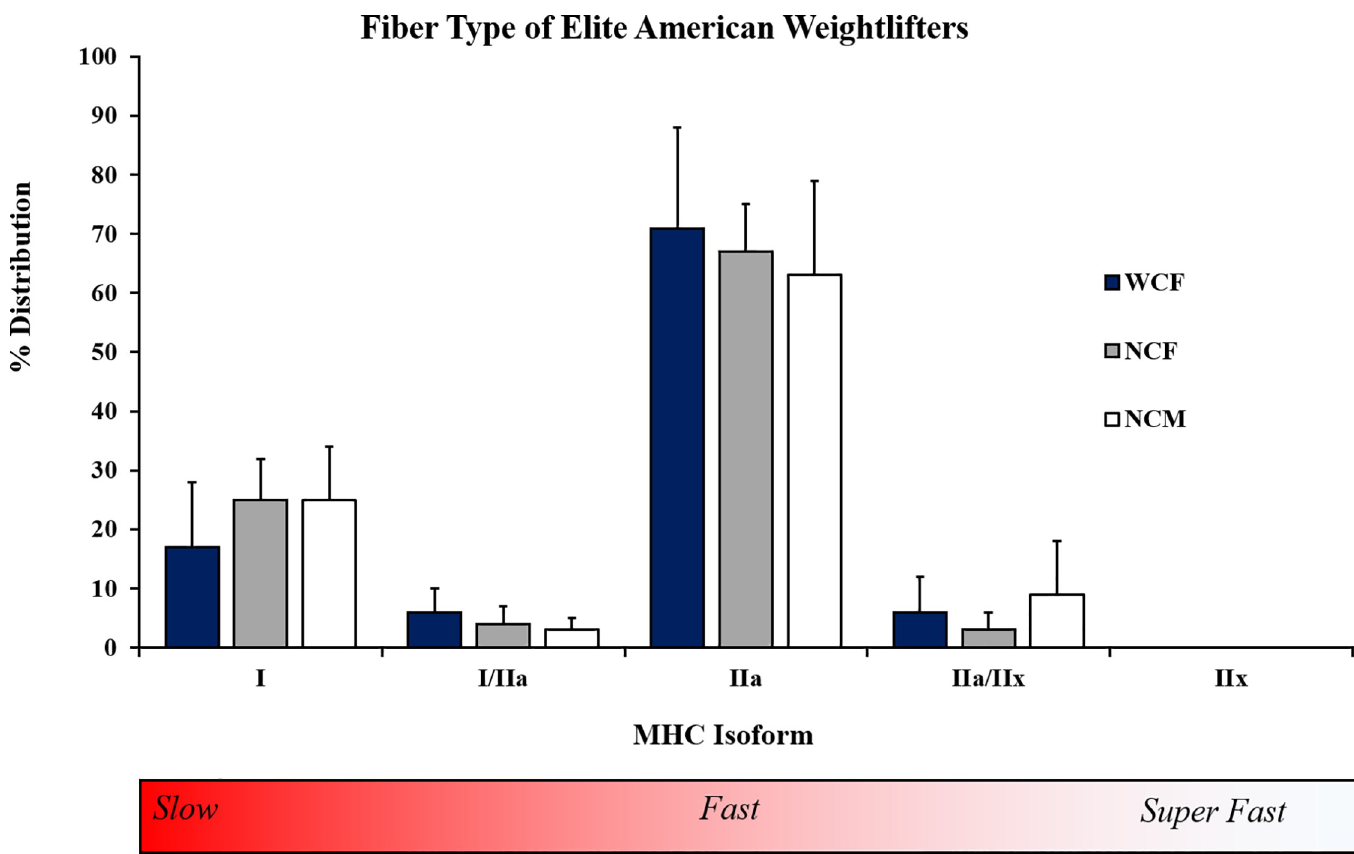
Fig 1. MHC FT% of elite American weightlifters. Data are reported as a percentage ± standard deviation.